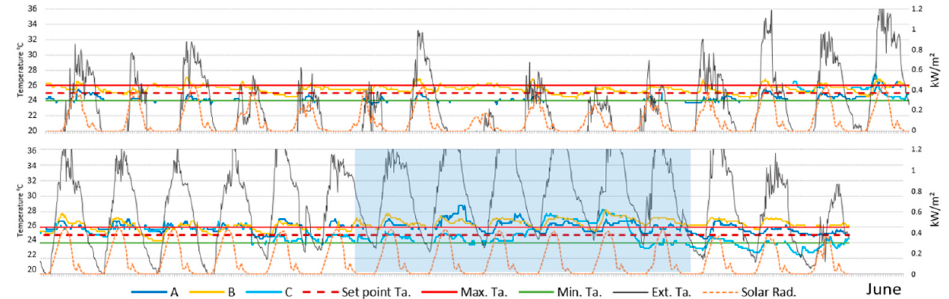
Figure 3. Monitored outdoor / indoor room temperature data and global solar radiation data for June 2018.